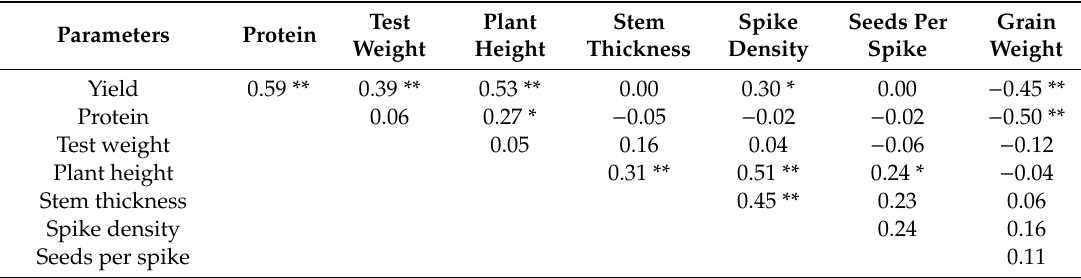
Table 3. Pearson correlation coefficients among yield, protein content, test weight, plant height, stem thickness, spike density (ear m − 2 ), seeds per spike, and grain weight for ORCF-102 across two growing seasons in Columbia Basin of Oregon ( n = 76).